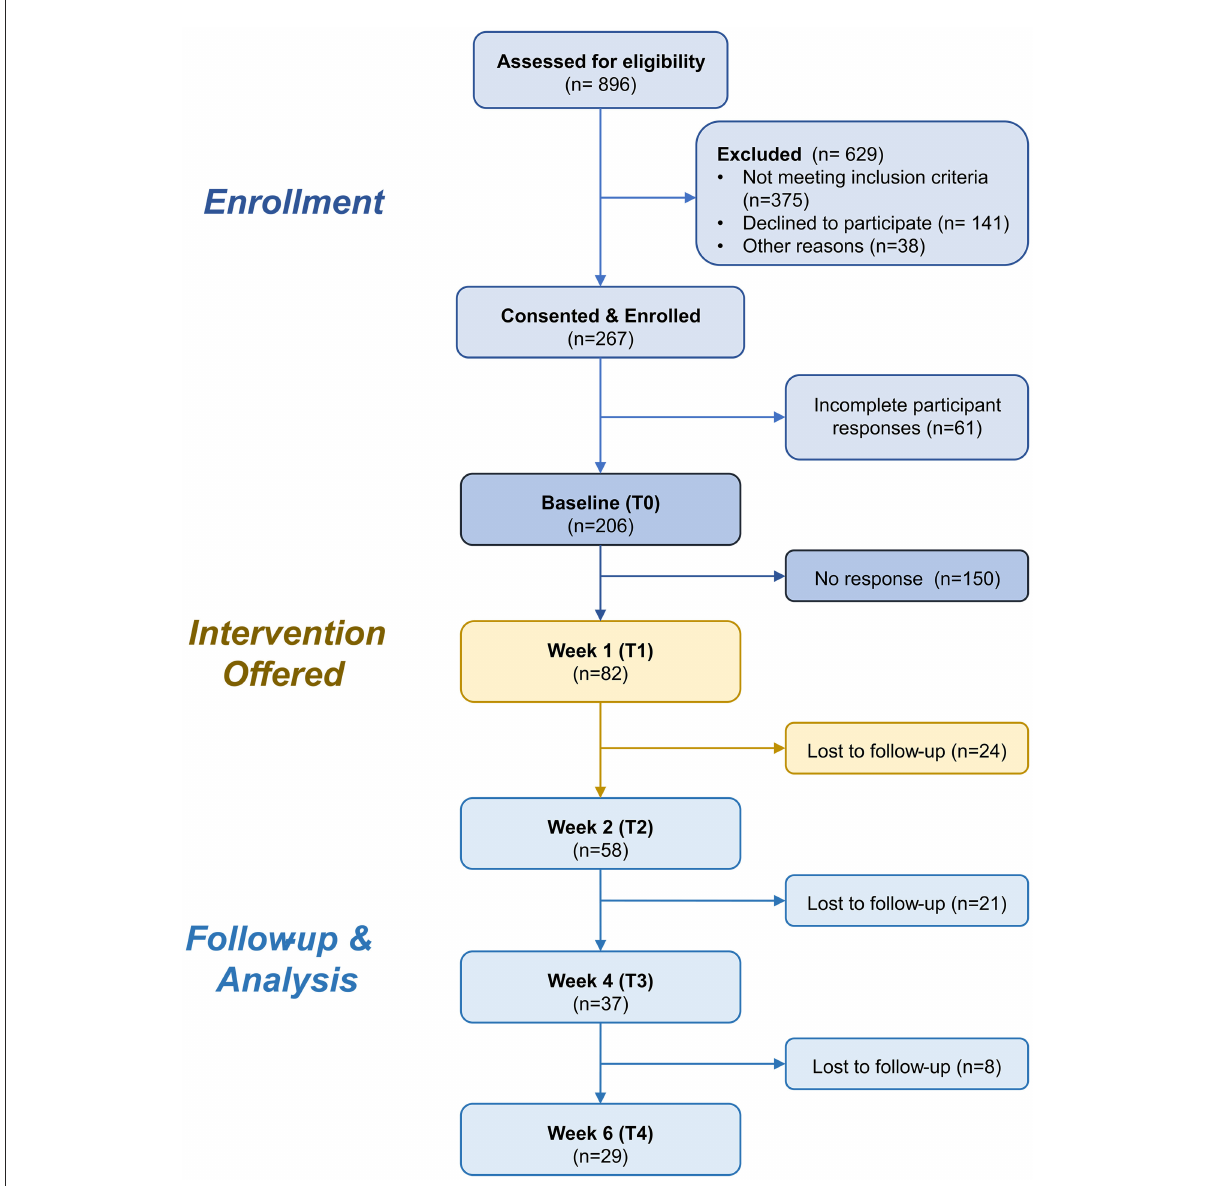
FIGURE1 CONSORT Chart. Flowchart showing the number of participants at each stage of the study.